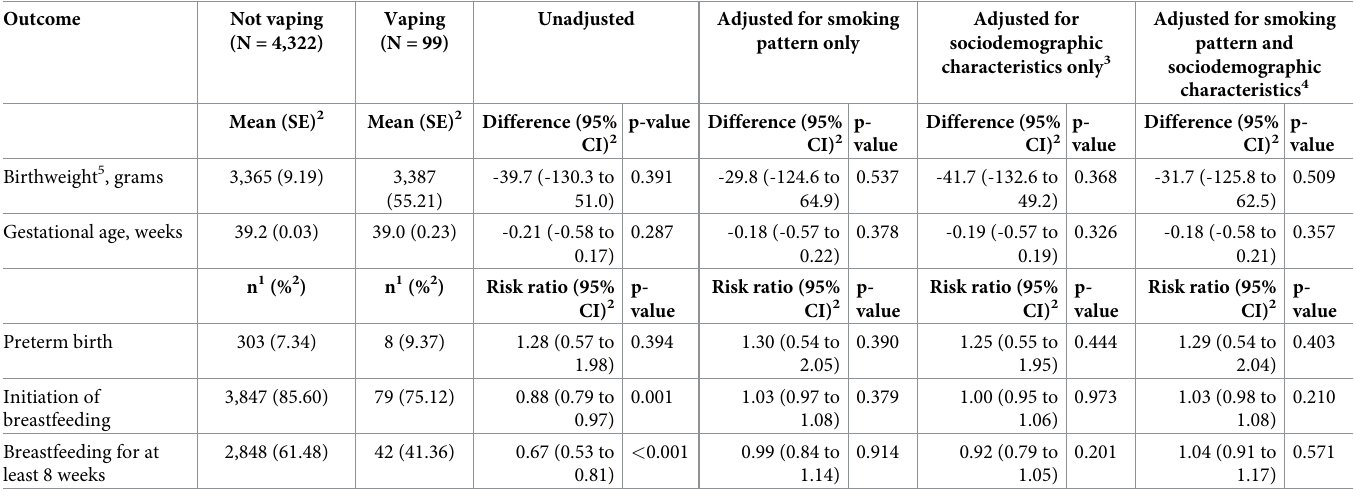
Table 4. Effects of vaping on birth outcomes and